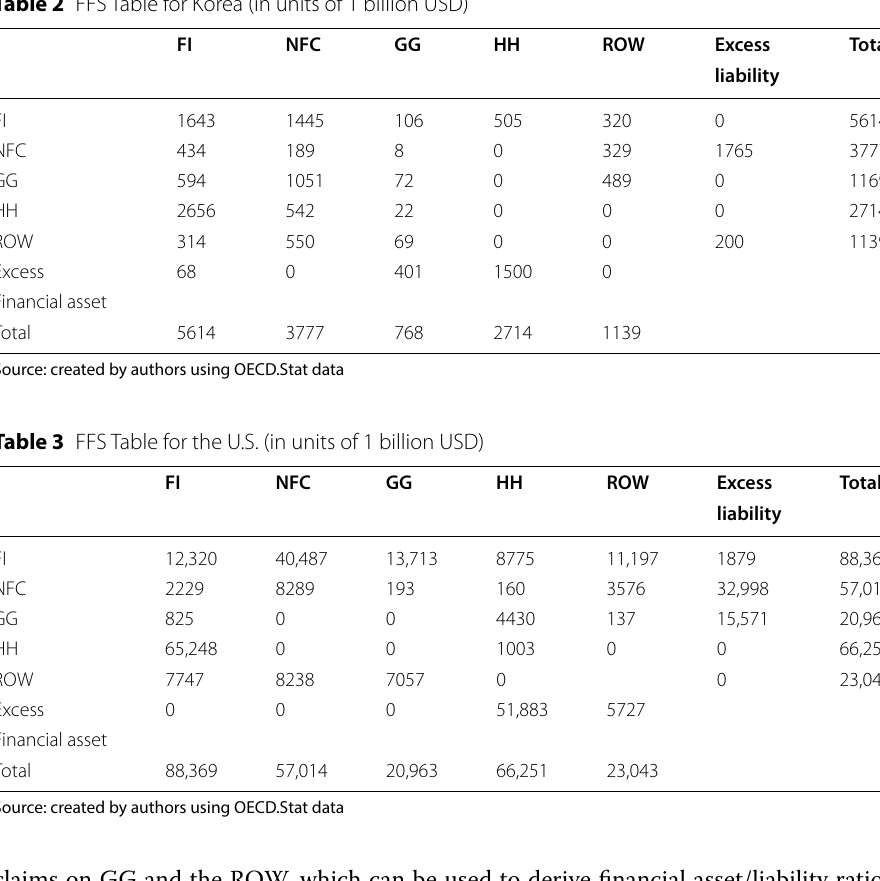
Table 2 FFS Table for Korea (in units of 1 billion USD) FI NFC GG